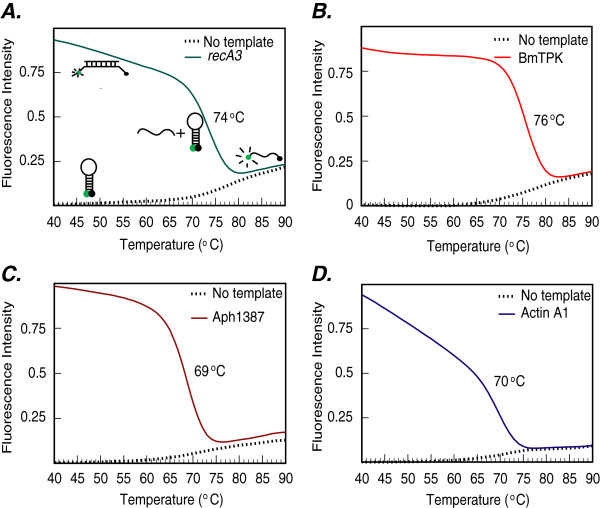
Denaturation profile analysis of molecular beacon probes used in this study. Melting curves of the RecA3 molecular beacon (A) in the presence of a complementary target sequence (green line), or in the absence of any target (buffer only control, dotted line) were generated. The fluorescence intensities indicate that the molecular beacon exists either as a hybrid with its perfect complementary target sequence, exhibiting high fluorescence from 25°C to 55°C, or in its free state in the form of a stem-loop structure with fluorescence quenched in a temperature range of 25–65oC as depicted by the cartoons. At higher temperatures (more than 70oC) the molecular beacon probe denatures and exhibits high fluorescence intensities in control. Similarly, probe-target hybrid also denatures at higher temperature releasing the target and diminishing the fluorescence as the probe returns to hairpin-loop structure. A similar analysis of the BmTPK, APH1387 and ACTA1 molecular beacon probes depicted a temperature and fluorescence profile (B, C, and D), which is similar to the RecA3 molecular beacon probe.